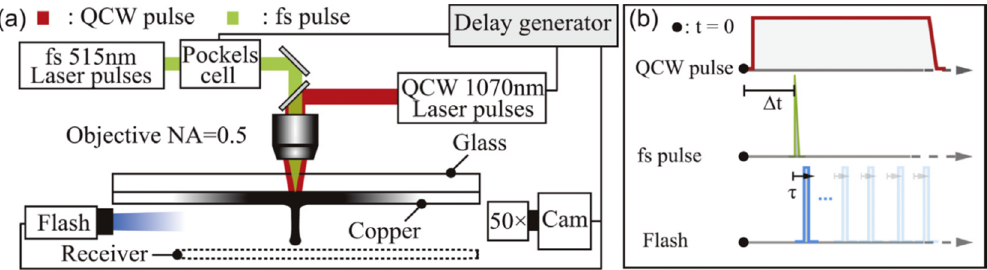
Figure 12. Schematic of the experimental setup for DP-LIFT. The femtosecond LIFT laser beam is represented in green and the quasi-continuous wave laser beam in red. Illumination flashlight is shown by the blue color ( a ). In ( b ), a time chart of events for synchronization of the DP-LIFT and time-resolved observations. Adapted from Reference [173].